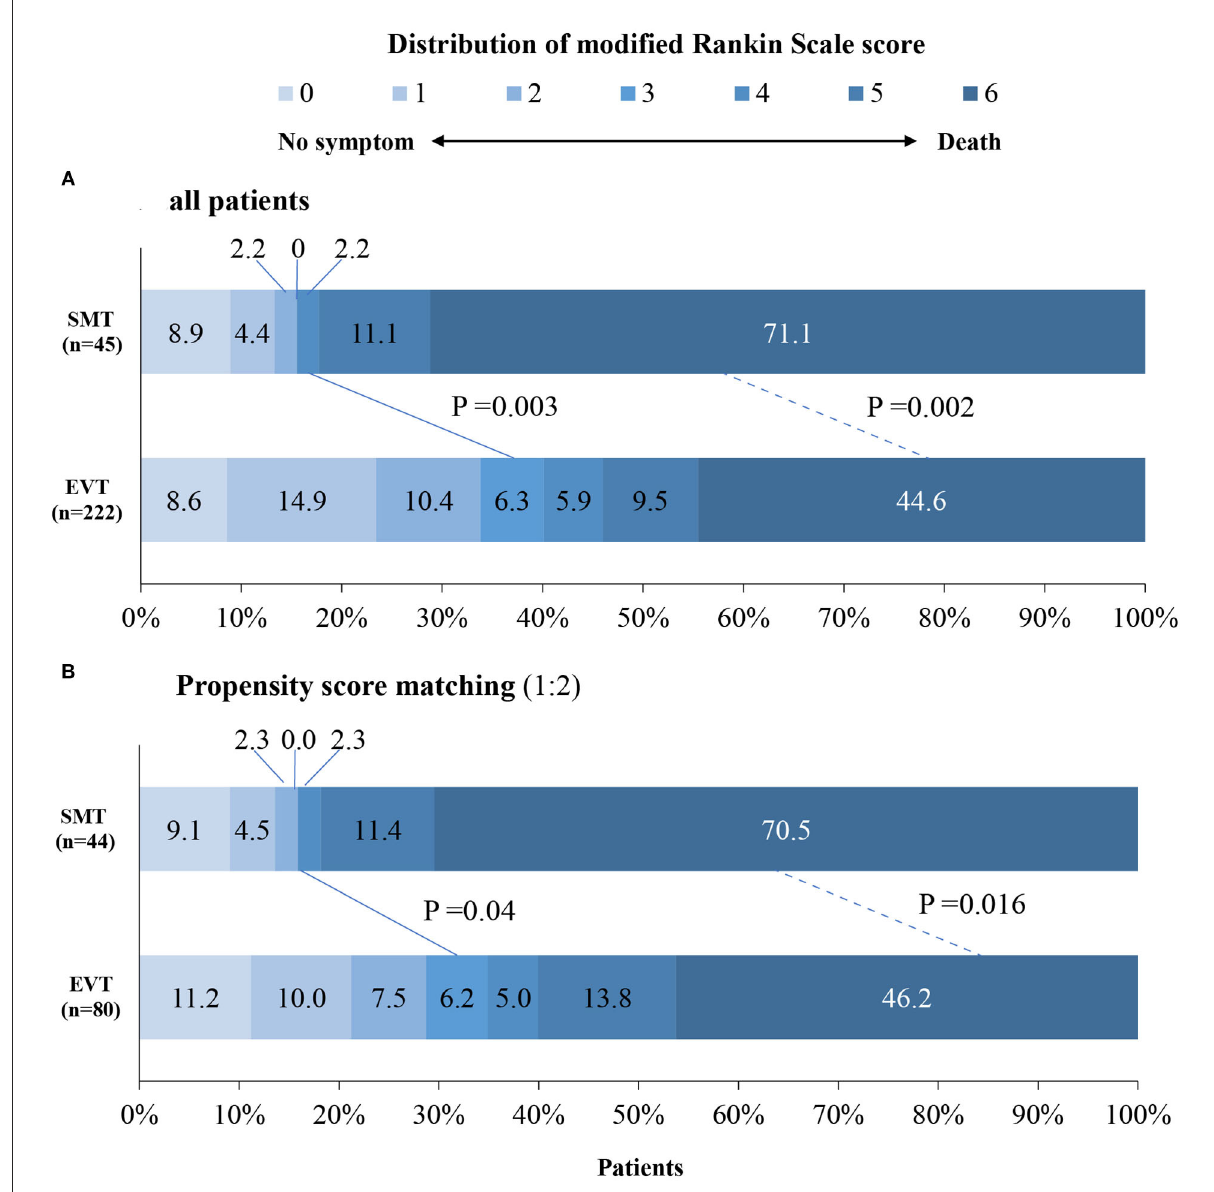
FIGURE1 Distribution of modified Rankin scale scores at day 90 in patients with distal BAO. The distribution of the modified Rankin scale scores at day 90 in patients with distal BAO is shown. Clinical outcomes at day 90 follow-up in patients in the SMT group vs. those of the EVT group (A) and clinical outcomes at day 90 follow-up after propensity score matching (B) . BAO, basilar artery occlusion; EVT, endovascular treatment; SMT, standard medical treatment.